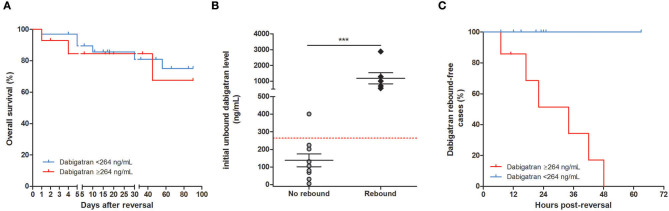
Initial plasma dabigatran level and biological or clinical outcomes. (A) Kaplan–Meier 90-day survival curve patients after idarucizumab administration according to baseline plasma dabigatran cutoff of 264 ng/mL. Percent survival rate was stratified by dabigatran plasma level at baseline < or ≥264 ng/mL for (n = 33 and 14, respectively) and did not significantly differ between groups (p = 0.36). (B) Initial plasma dabigatran concentrations in patients according to the presence or absence of dabigatran rebound after idarucizumab. Among the 87 patients who had a laboratory test prior to idarucizumab injection, only 16 had plasma dabigatran determination both at baseline and during follow-up. At baseline, patients with no rebound had a significant lower mean of dabigatran level (138 ng/mL ± 114, p = 0.0002) than patients with rebound (1,189 ng/mL ± 869). The dashed red line is a reference line indicating the predefined cutoff of 264 ng/mL. (C) Proportion of cases of dabigatran rebound after reversal according to the cutoff of 264 ng/mL before reversal. No dabigatran rebound was observed after reversal in patients with dabigatran <264 ng/mL at baseline (n = 9, blue bar). Among patients with dabigatran ≥264 ng/mL at baseline, rebound was observed in six patients within a median time of 34 h post-reversal (red bar).